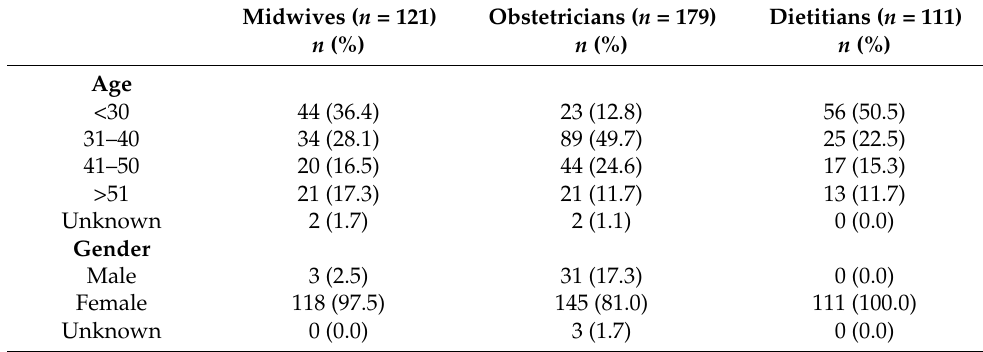
Table 1. Characteristics of responding midwives, obstetricians, and dietitians.